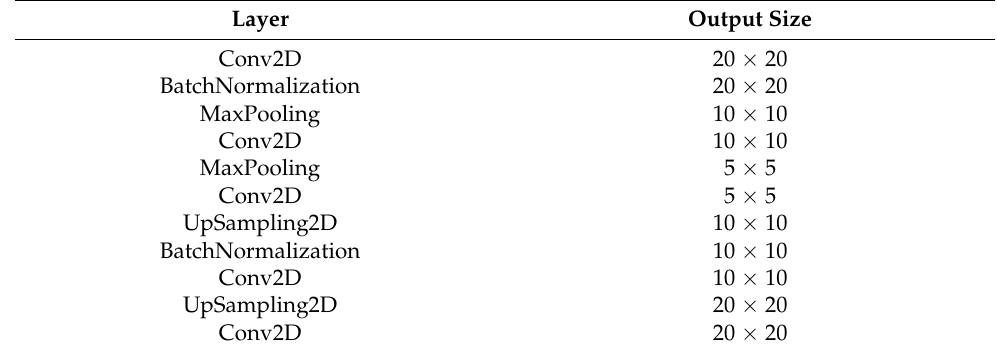
Table 1. DAE architecture summary.